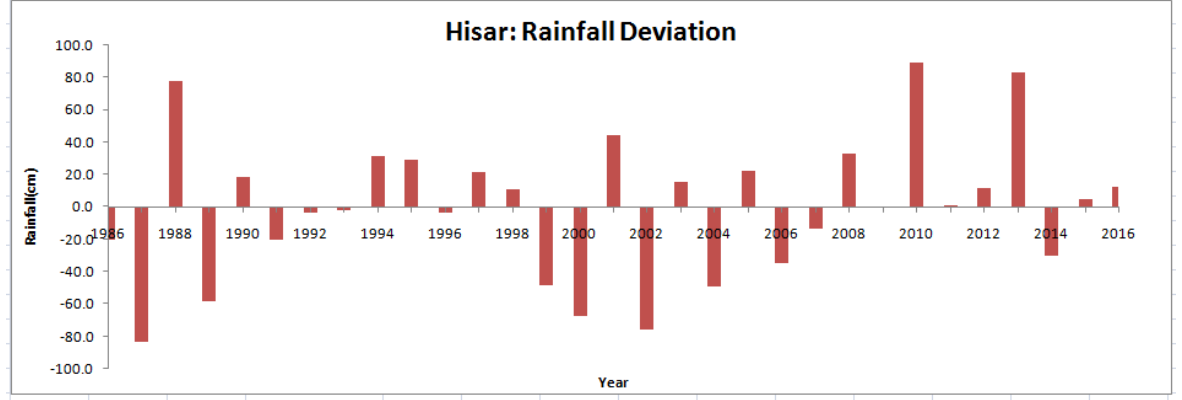
Figure 5: Rainfall Deviations from Long Period Average of Normal Rainfall for Baseline Period (1986-2016): HISAR